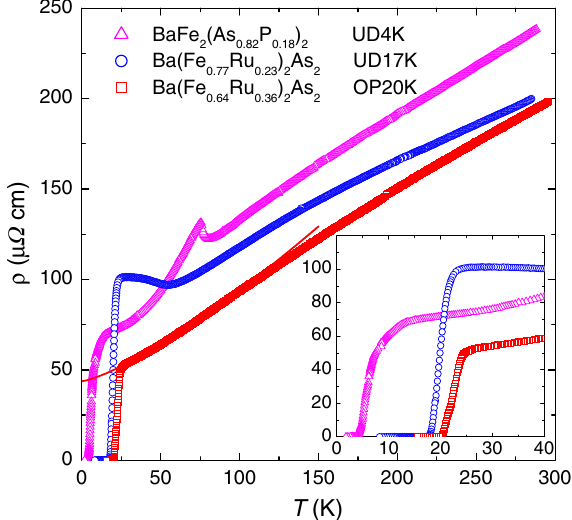
FIG. 2. In-plane electronic resistivity of Ba ð Fe 0 : 64 Ru 0 : 36 Þ 2 As 2 , Ru Þ As BaFe ð As P Þ Ba ð Fe 0 : 77 0 : 23 2 2 , and 2 0 : 82 0 : 18 2 single crystals. The low-temperature superconducting transitions are shown in the inset. Defined by (cid:3) ¼ 0 , the transition temperatures T c ¼ 20 , 17, and 4 K are obtained; correspondingly, these three samples are named OP20K, UD17K, and UD4K, respectively. The solid line is a fit of the data between 30 and 90 K to (cid:3) ð T Þ ¼ (cid:3) 0 þ AT n for the